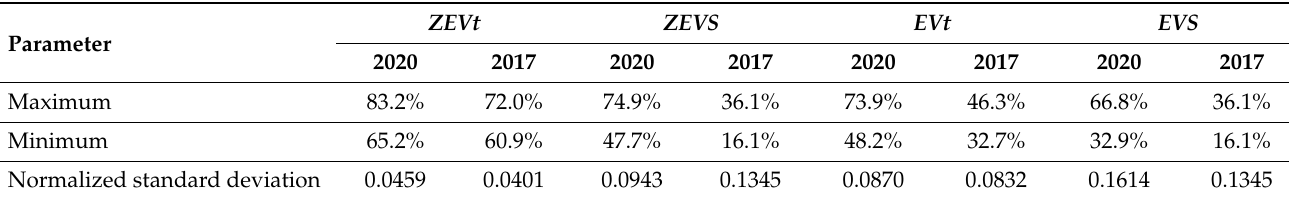
Table 3. Maximum values, minimum values and normalised standard deviation of the parameter values for the analysis of vehicle operation in zero-emission vehicle (ZEV)